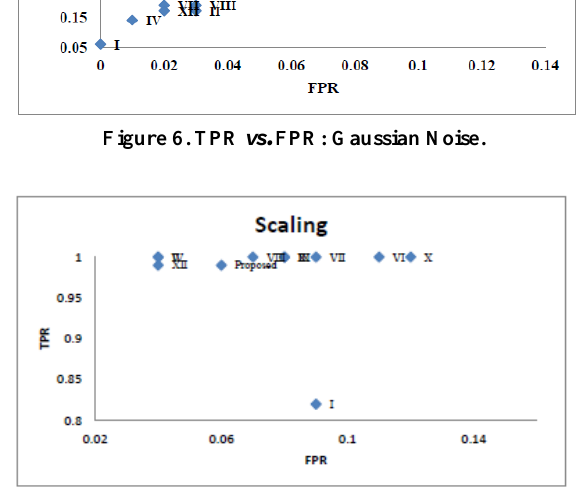
Figure 7. TPR vs. FPR: Scaling.